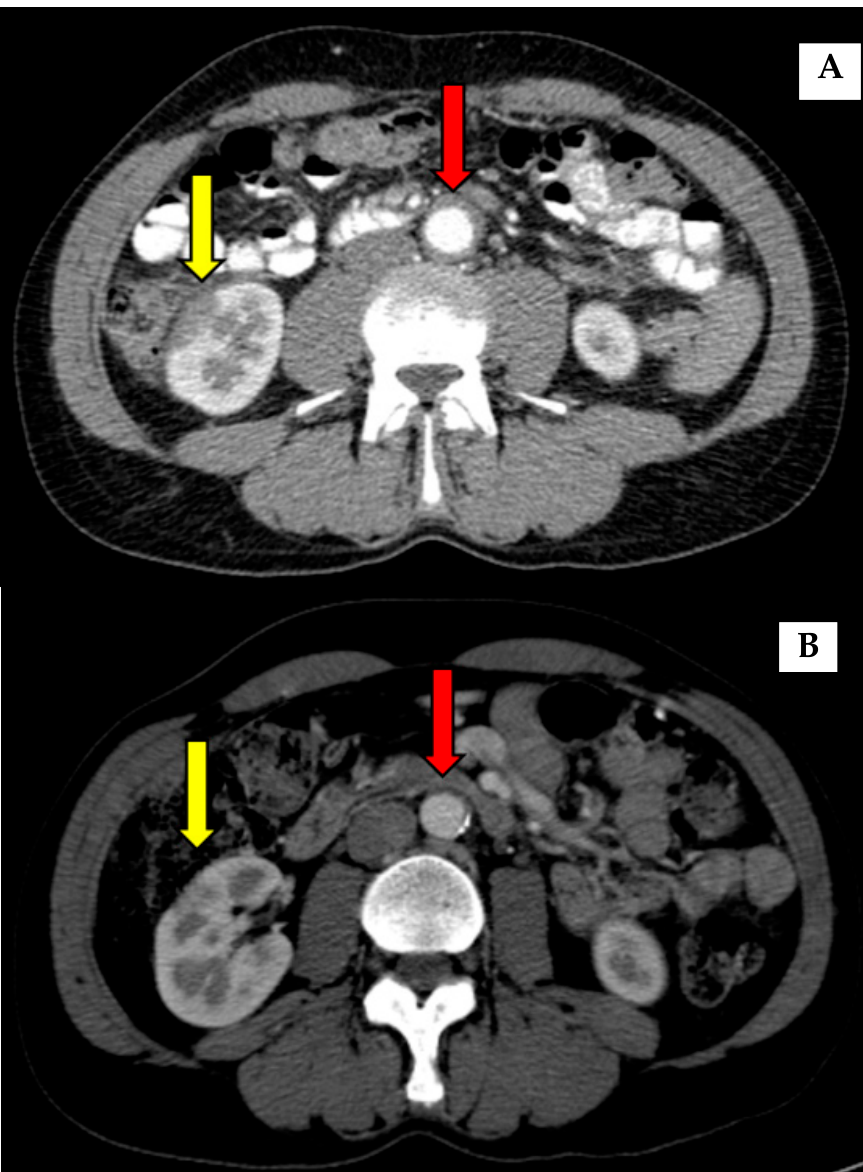
Figure 3. Inflammatory changes in aorta-thickening of aorta wall before ( A ) and after ( B ) corticosteroid treatment (red arrow). An improvement of kidney involvement after the treatment was also seen (yellow arrow).